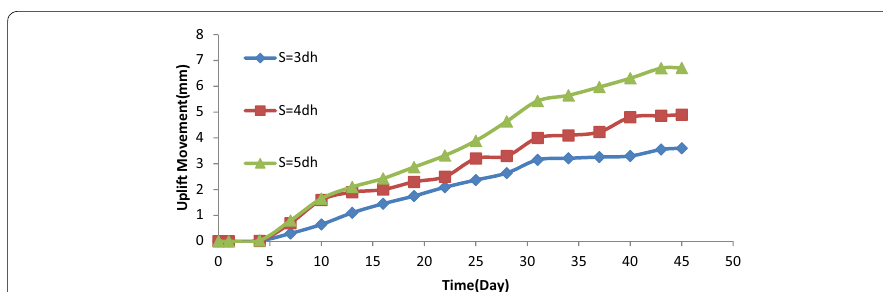
Fig. 31 Variation of uplift movement with time for pile group of L/D